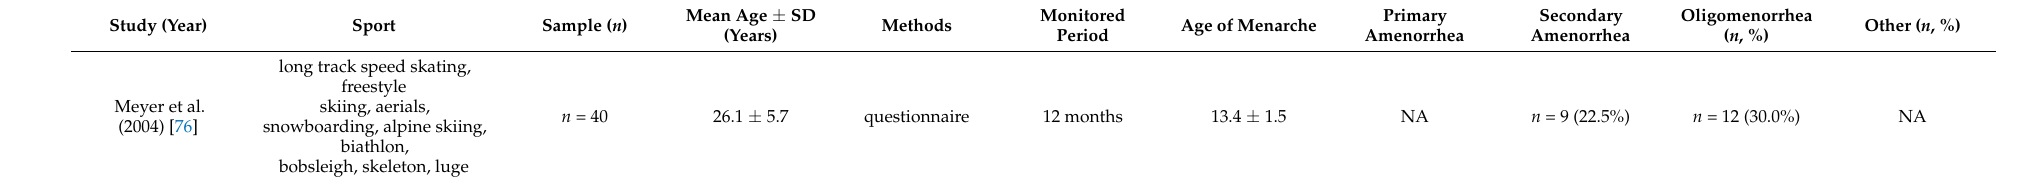
Table 5. Sample characteristics, menstrual disorders measurement and prevalence in winter and outdoor